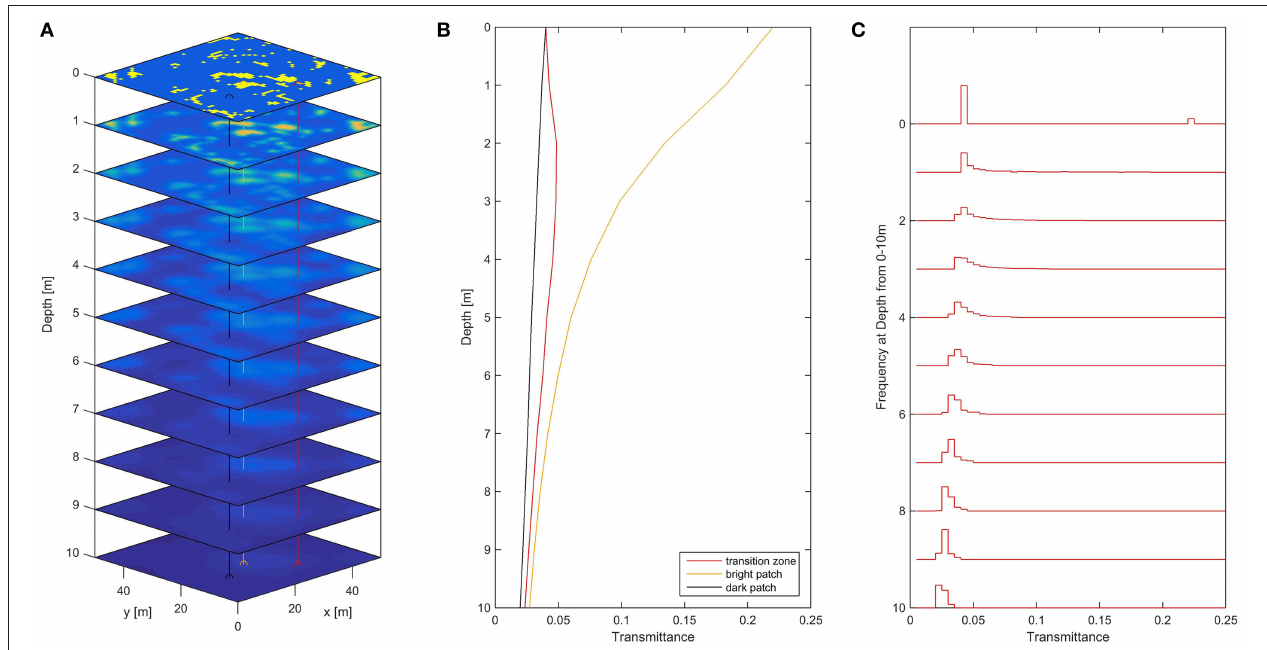
FIGURE 8 | (A) Depth slices of the light field underneath a real surface geometry extracted from an aerial image and idealized by classification into two transmittance classes. Bright colors show high light transmittance. (B) Vertical irradiance profiles extracted at three different close lying locations indicated in (A) . (C) Probability distributions of the under-ice light field as measured in depths from 0 to 10 m.